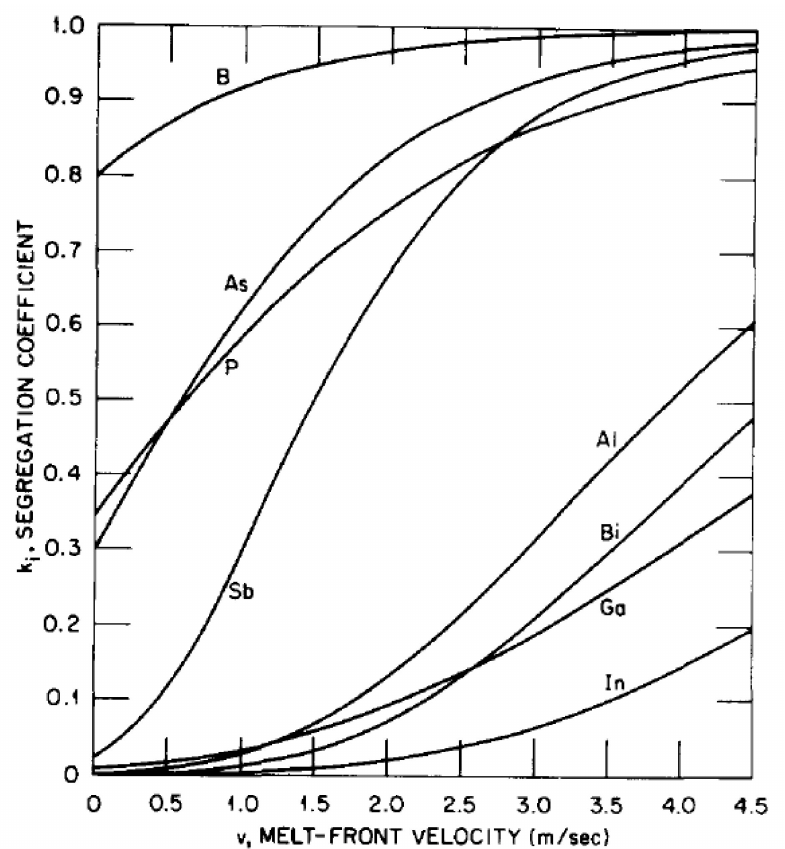
Figure 5. An example of the theoretically predicted dependence of the segregation coefficient ( k i ) of dopants in Si on the solidification front velocity (i.e., the melt–front velocity, v ). Reprinted with permission from Ref. [48]. 1980, AIP Publishing.